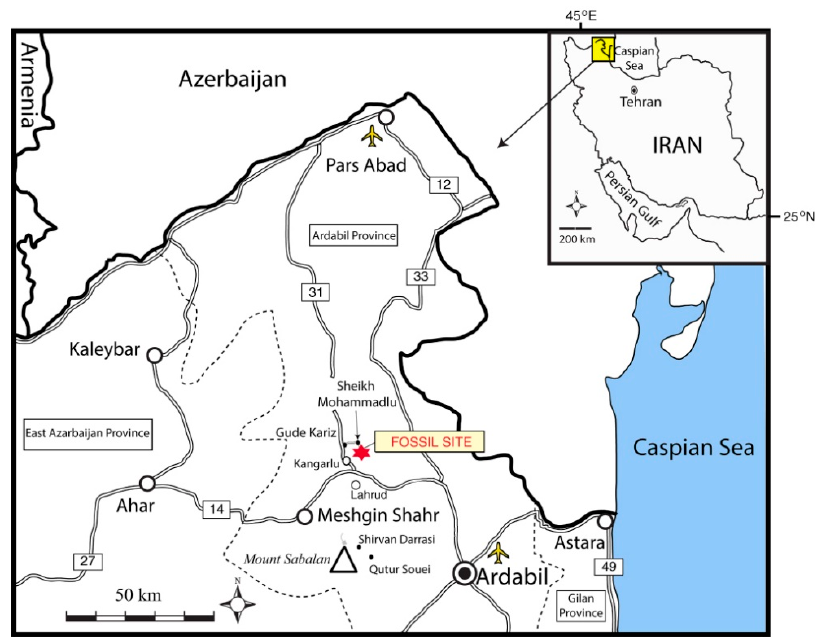
Figure 1. Location map of tree trunk fossil site in the northwest Ardabil, NW.